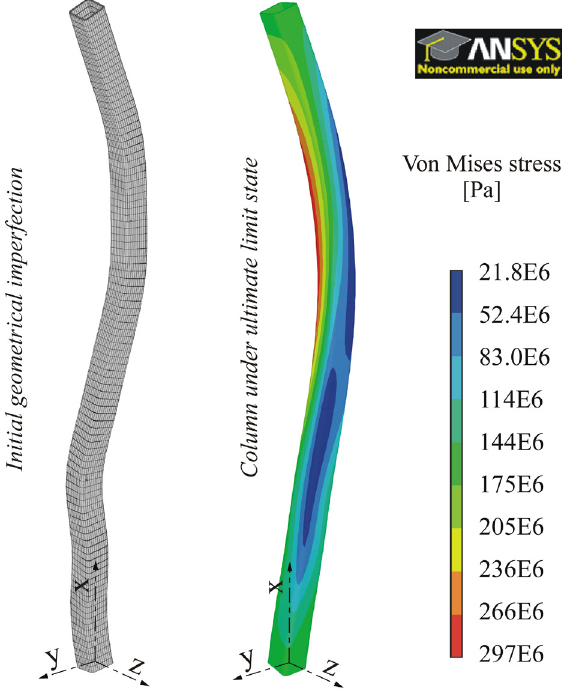
Fig. 7. Comparision of von Mises stress of two columns at ultimate limit